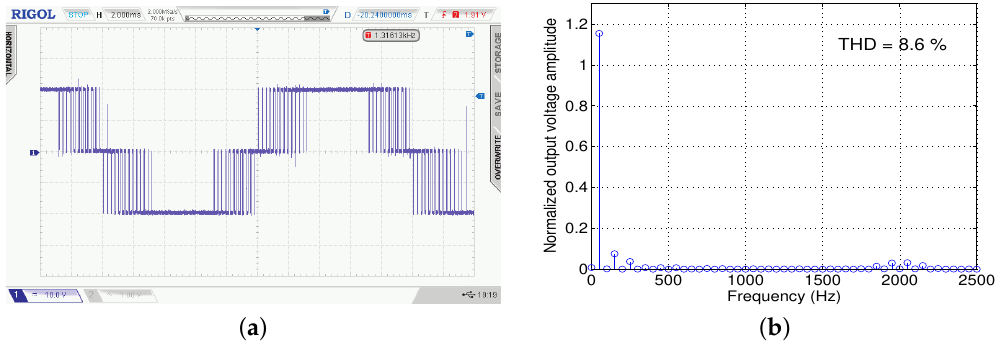
Figure 13. ( a ) Inverter output voltage with SPWM at m I = 1.2 and ( b ) Its frequency spectrum.